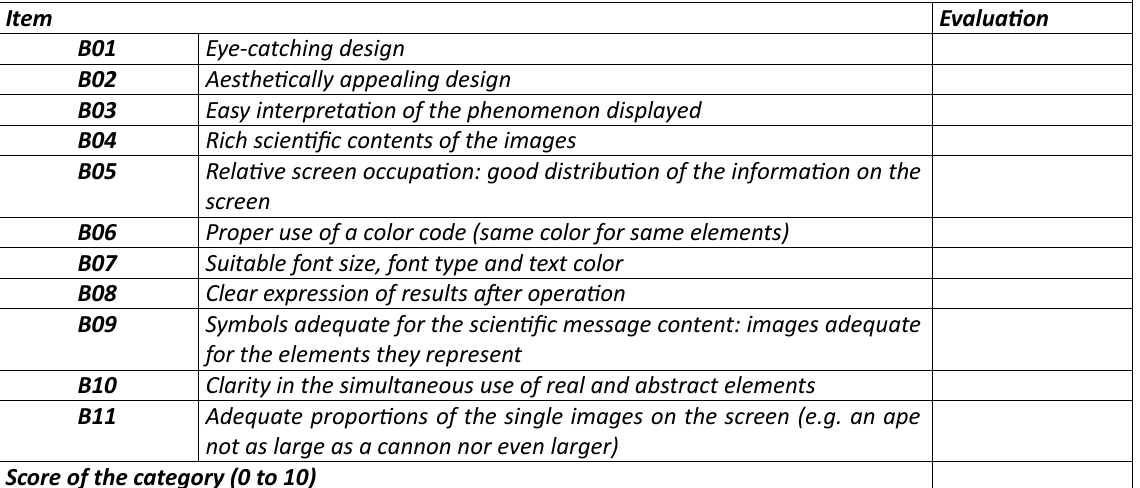
Table 1. Evaluation Questionnaire (first